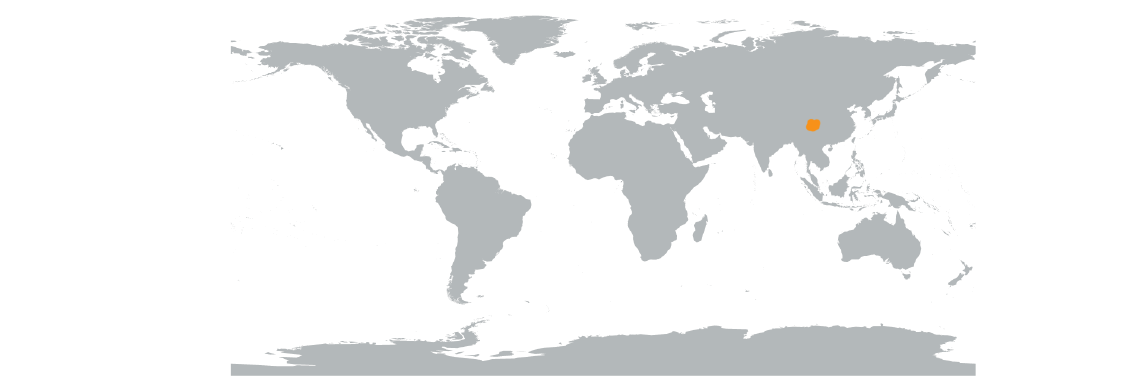
Fig. 29. Distribution of Malus xiaojinensis M.H.Cheng &